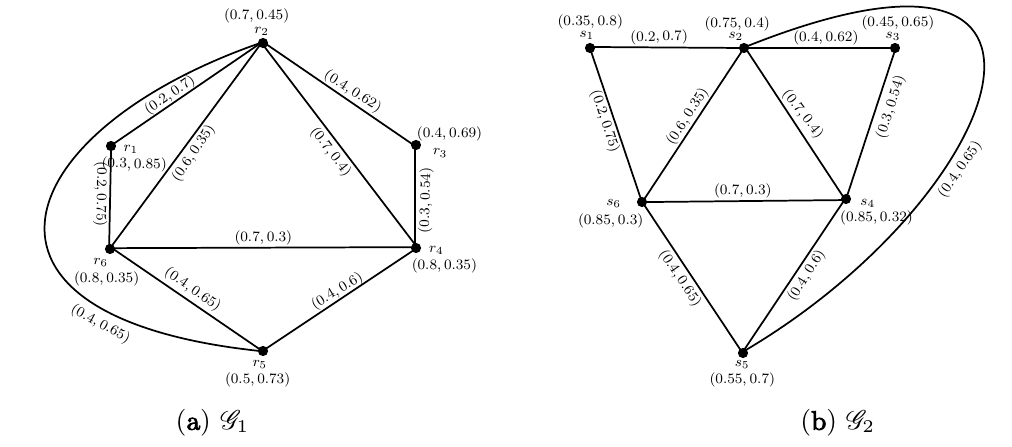
Figure 6.3: Pythagorean fuzzy planar graphs Figure 14. Pythagorean fuzzy planar